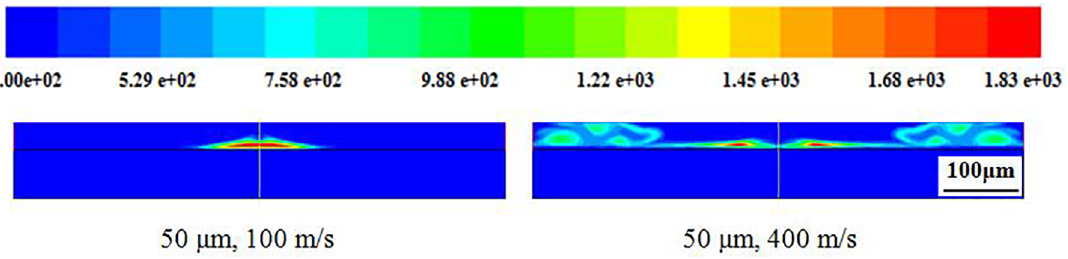
Fig. 12 reveals the relationships between temperature and time, and the maximum temperature value is extracted at different time for a 50 µm diameter droplet. It can be seen that the cooling of the droplet is quite fast at the range of 0~10 µs. The temperature decreasing procedure is extended roughly to 50 µs. After 50 µs, all molten droplets tend to near room temperature, and these can be calculated from the rate of solidification of the molten droplet range of 3.1~7.6 (×10 7 K/s). Therefore, twin-wire arc sprayed coating has a characteristic of rapid solidification.